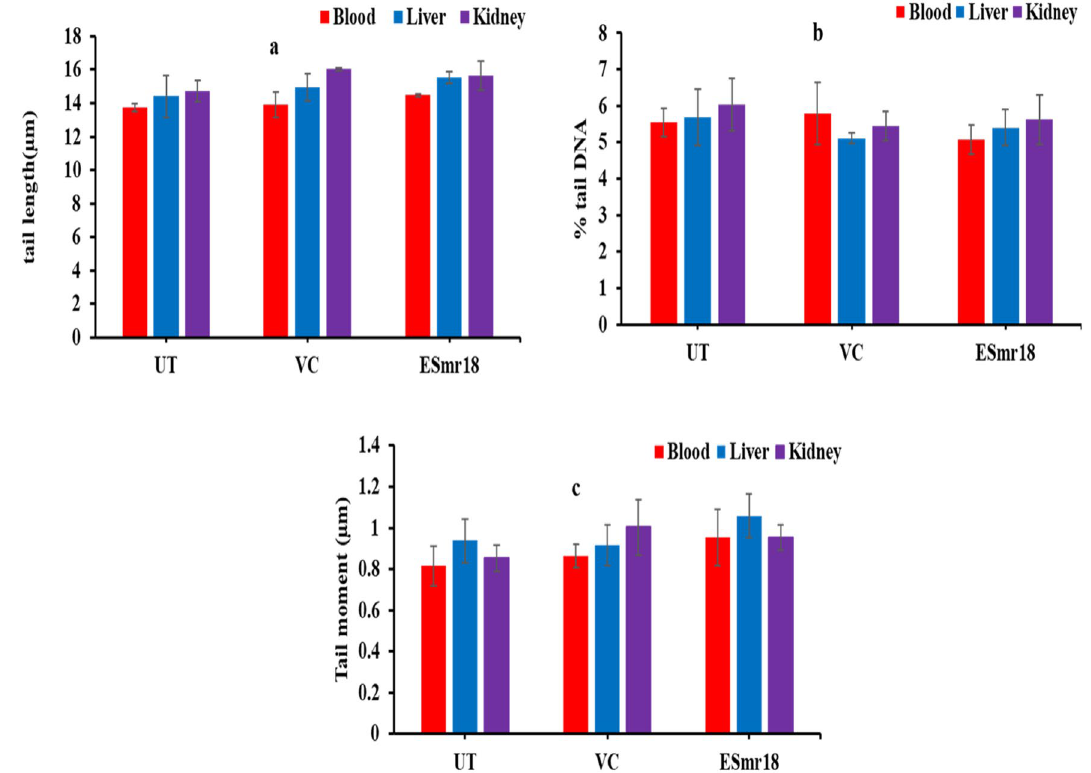
Fig. 6 Effect of crude ESmr18 on tail length ( a ) % tail DNA ( b ) and tail moment ( c ) in blood, liver, and kidney cells of C. mrigala . Error bars are representative of mean SD of the experiment performed in triplicates. a Indicates significant (p < 0.05) difference of the treated groups when ± compared with